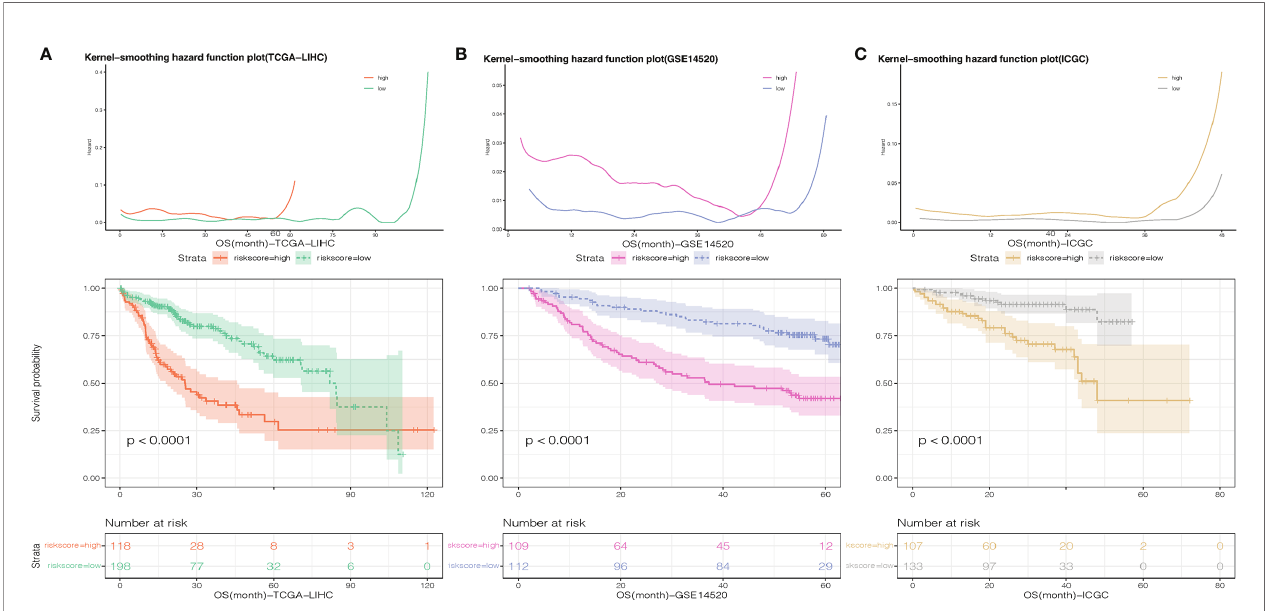
FIGURE 4 | Smoothed hazard estimates of patients with low- and high-NRS according to survival analysis. (A) TCGA-LIHC, (B) GSE14520, (C)